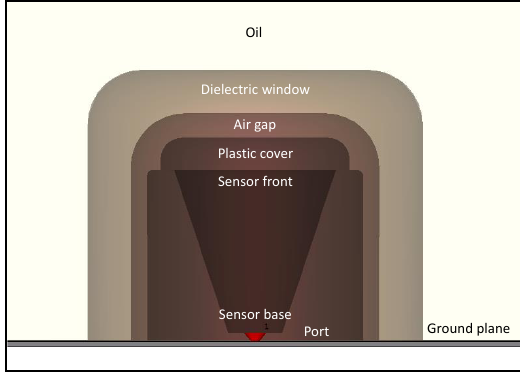
Figure 3. Simulation setup of the window-type sensor in oil.